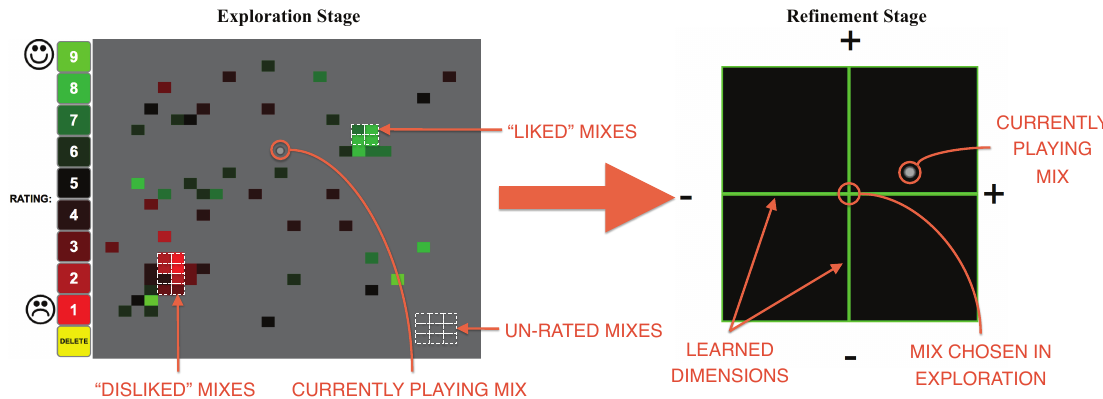
Figure 8. Mixploration is a tool for finding diverse mixes that separates the mixing process into two stages: exploration and refinement. ( left ) In the exploration stage, the user navigates the space of mixes on a 2D grid and rates how much they like the mixes they hear. ( right ) In the refinement stage, the user refines their favorite mix using a 2-dimensional slider, in which the dimensions are learned from the ratings in the exploration stage. Figure created by the